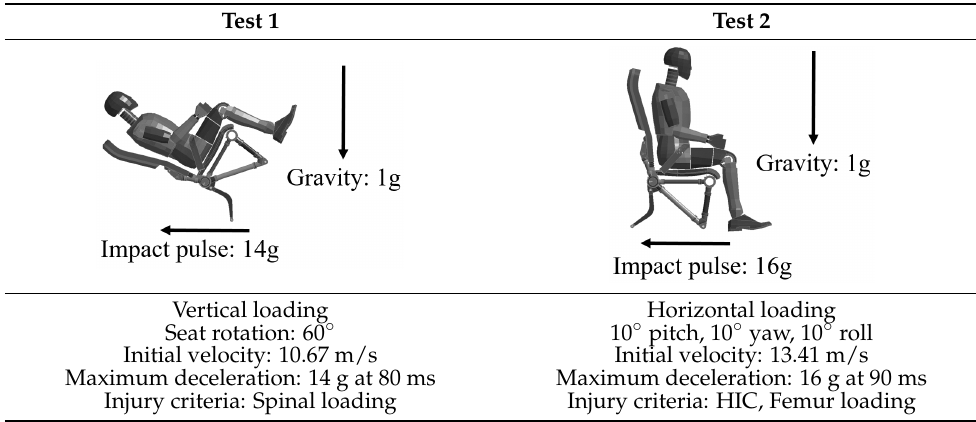
Table 1. Summary of the dynamic tests of CFR 25.562.